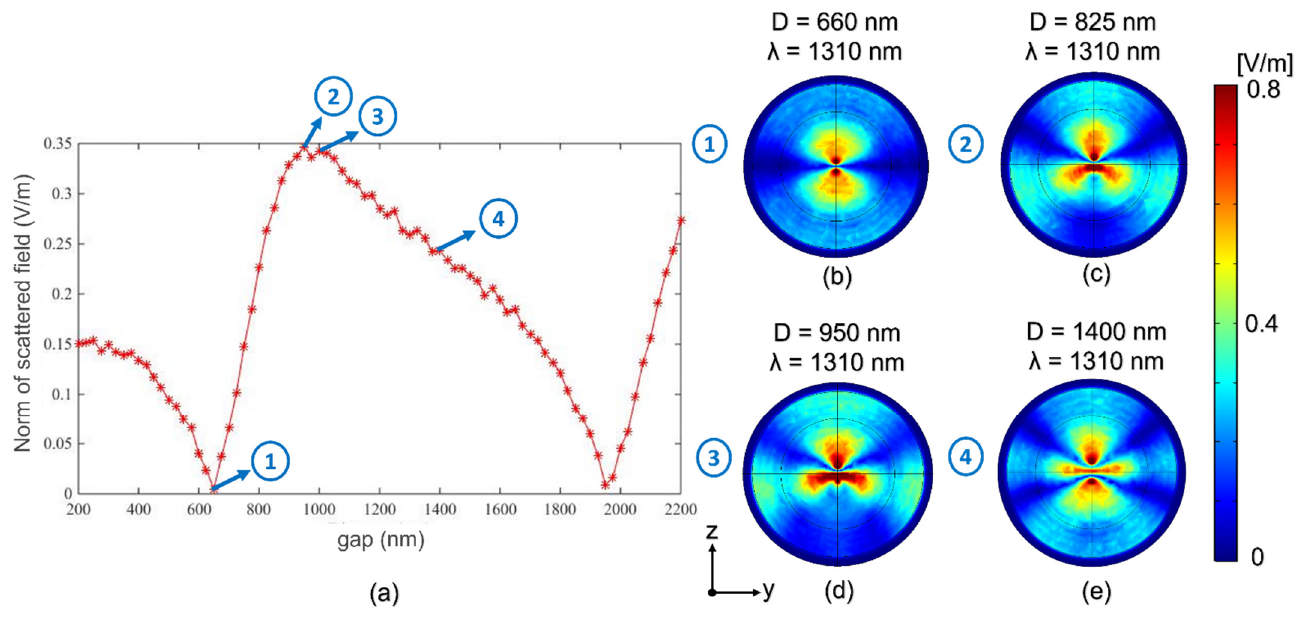
Figure 4. ( a ) Norm of the scattered field versus distance between nanocylinders for an incident wavelength λ = 1310 nm. Scattered field patterns at ( b ) D = 660 nm. ( c ) D = 825 nm. ( d ) D = 950 nm. ( e ) D = 1400 nm.